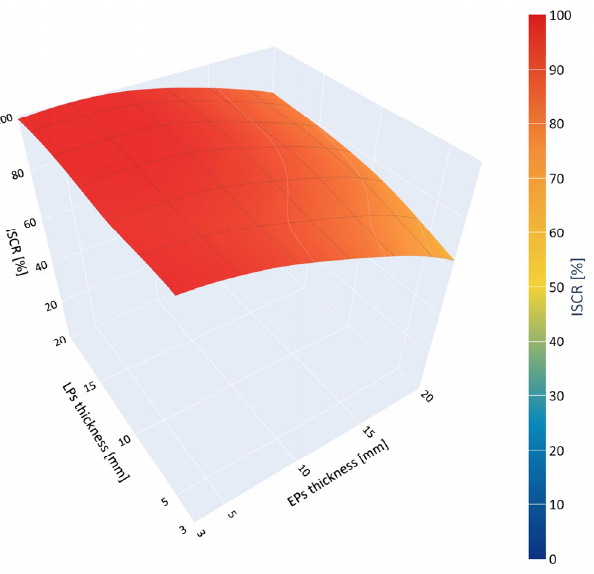
Figure 5. Response surfaces of the maximal ISCR in relation to the two traction ba tt ery housing variables for Concept Y with cell B. variables for Concept Y with cell